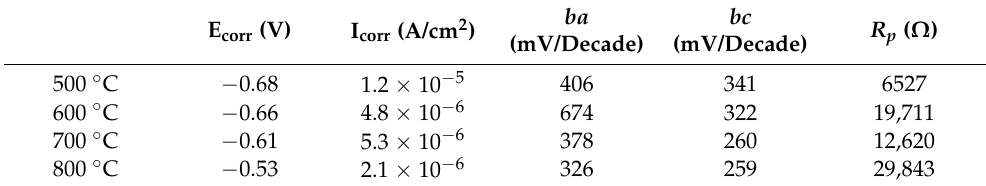
Table 2. Polarization curve corrosion parameters.